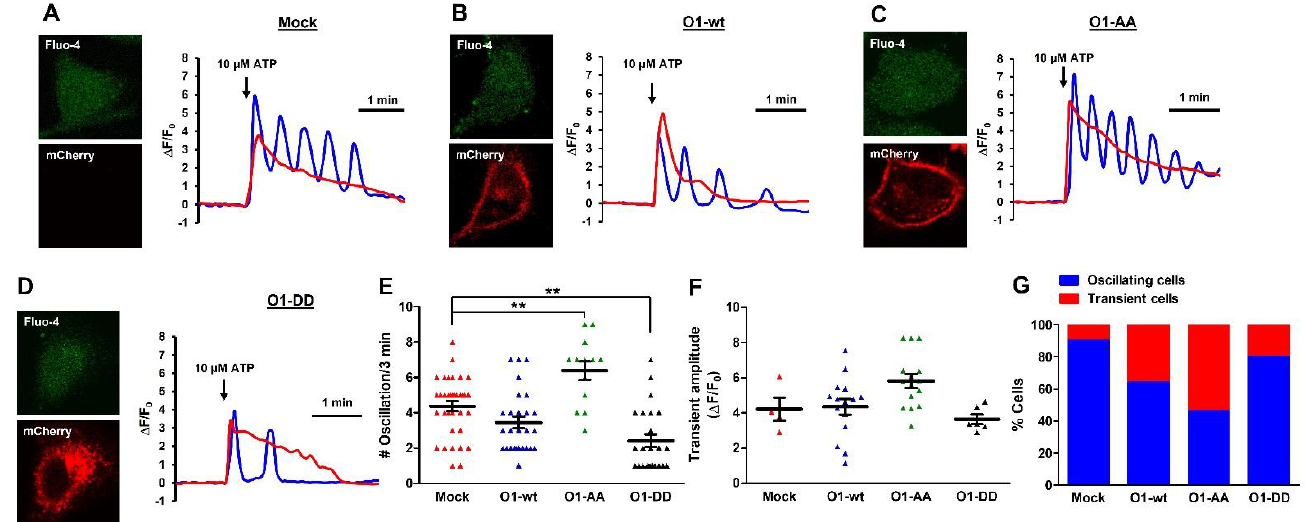
Figure 7. The O1-DD channel inhibited while the O1-AA channel stimulated the frequency of ATP- induced [Ca 2+ ] i oscillations in the absence of thapsigargin. ATP (10 µ M)-induced Ca 2+ mobilization displayed two different types of responses, oscillations (blue traces) and a transient elevation (red trace) in mock HeLa cells ( A ) or cells expressing mCherry-O1-wt ( B ), mCherry-O1-AA ( C ), or mCherry-O1-DD ( D , E ). To determine whether the [Ca 2+ ] i oscillations frequency was modified by the different ion channels, the number of oscillations was determined in the same 3 min period. Mock cells had 4.4 oscillations in this time, while the expression of O1-wt did not significantly modify this frequency (3.4), but O1-AA significantly increased it to 6.4 and O1-DD decreased it to 2.4. The O1-DD channel reduced the frequency to the extent that, now, most cells displayed a single oscillation in the same period. ( F ) The peak amplitude of the transient [Ca 2+ ] i response was not significantly modified by expressing any of the O1 channels. ( G ) Percentage of cells either oscillating (blue bar) or with transient [Ca 2+ ] i responses (red bar). Traces show representative recordings for each condition. ** p < 0.01 for a minimum of four independent